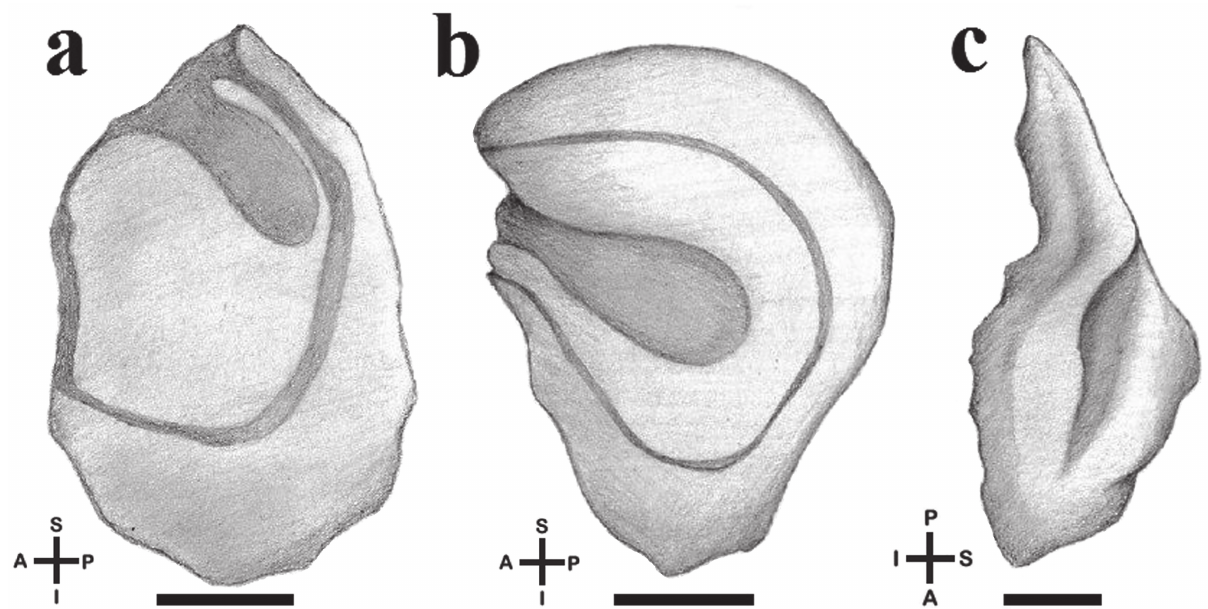
Fig. 5. Right serie of otoliths of Rineloricaria catamarcensis (a) Lapillus, Scale bar = 200 µm; (b) Asteriscus, Scale bar = 200 µm; (c) Sagitta, Scale bar = 200